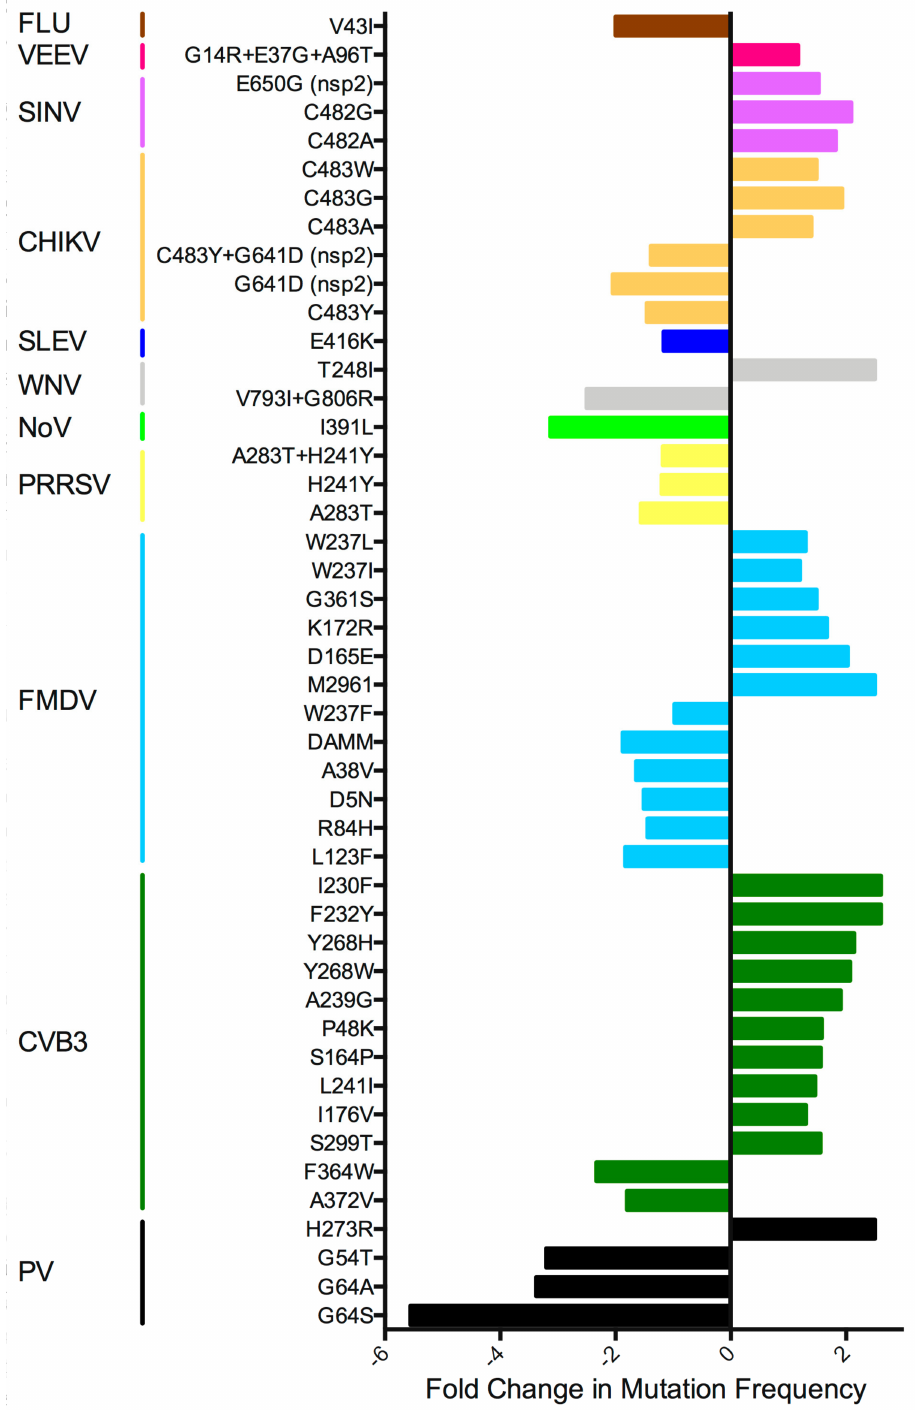
Figure 2. Fold-change in fidelity mutant mutation frequency relative to the wt virus. Most estimates are from TOPO cloning experiments, but if this information was not available, fold-change NGS data was used. Fidelity-altering mutations found outside the RdRp gene are indicated. Coronavirus data was excluded due to exceptional differences during RNA replication compared to the other RNA viruses. HEV71 data was excluded as mutation frequency was only reported for virus in the presence of ribavirin. FLU: influenza virus; VEEV: Venezuelan equine encephalitis virus; SINV: sindbis virus; CHIKV: chikungunya virus; SLEV: St. Louis encephalitis virus; WNV: West Nile virus; NoV: norovirus; PRRSV: porcine reproductive and respiratory syndrome virus; FMDV: foot-and-mouth disease virus; CVB3: coxsackievirus B3; PV: